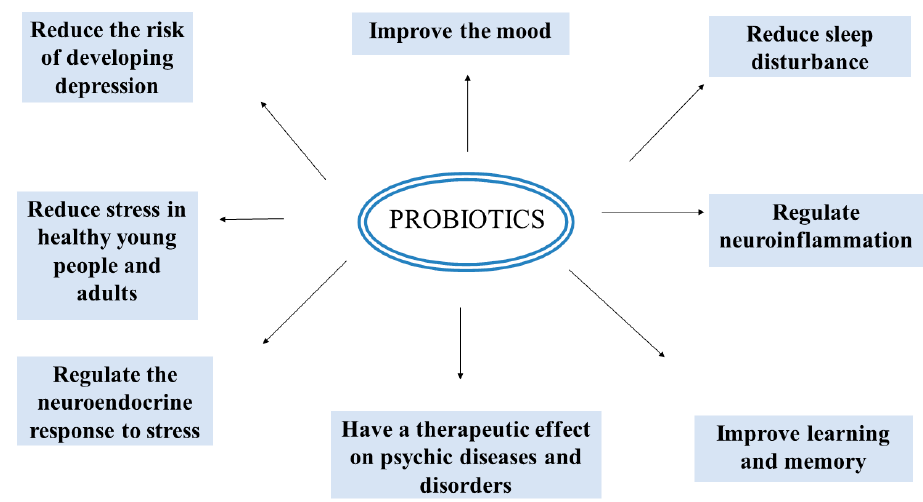
Figure 2. Some important effects of probiotics on mental well-being.